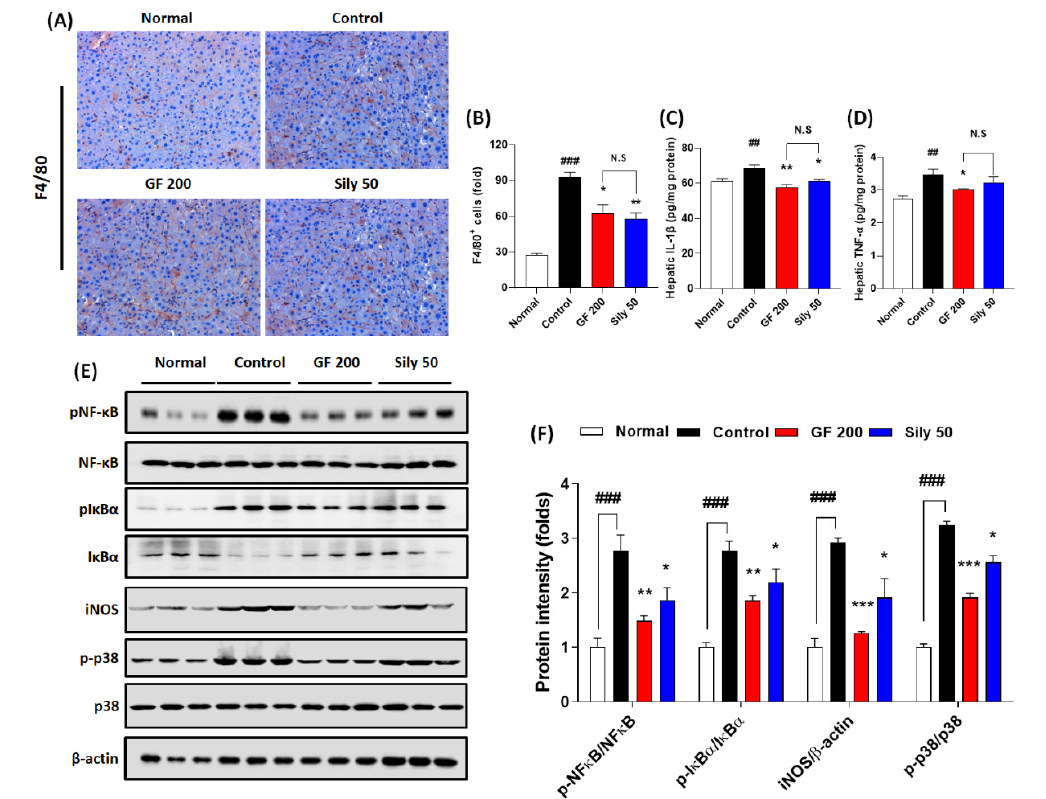
Figure 3. Effects of GF on TAA-injected hepatic inflammation. ( A ) IHC analysis against F4/80 and ( B ) quantification analysis. ( C ) Hepatic protein levels of IL-1 β and ( D ) TNF- α . ( E ) Western blot analysis of inflammatory related proteins including p-NF- κ B, NF- κ B, p-I κ B α , I κ B α , iNOS, p-p38, and p38 and ( F ) protein intensity. Data were expressed mean ± SEM ( n = 4 for each group in IHC analysis; n = 9 for each group for IL-1 β and TNF- α ; n = 3 for each group in Western blot analysis). N.S, not significant, ## p < 0.01 and ### p < 0.001 for Normal vs. Control; * p < 0.05, ** p < 0.01, and *** p < 0.001 for Control vs. GF 200 or Sily 50. H&E staining images were captured by light microscope condition (400-× magnifications).